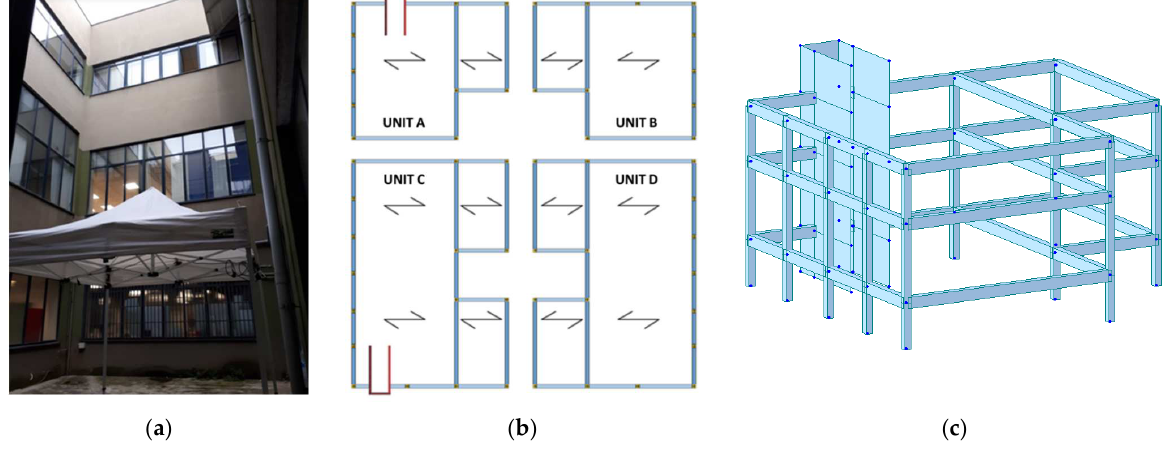
Figure 4. Case study building: ( a ) picture of the building exterior from the courtyard; ( b ) structural scheme of the building, with identification of the four independent units and the direction of spanning of the floors; ( c ) view of the 3D numerical model of unit A. The basement of the building hosts technical rooms and laboratories; the first level includes a cafeteria and a gym, whereas the second level is allocated to offices. From a of seismic joints (Figure 4b). Table 2. Interstory heights and floor masses of unit A of the considered case study building. Floor Levels Interstory Height (m) Mass (t)